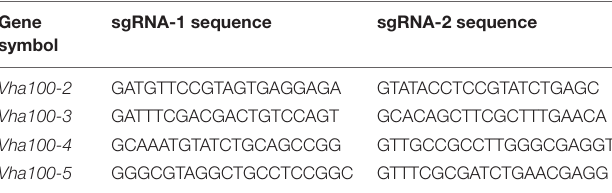
TABLE 2 | Summary of CRISPR-Cas9 sgRNA